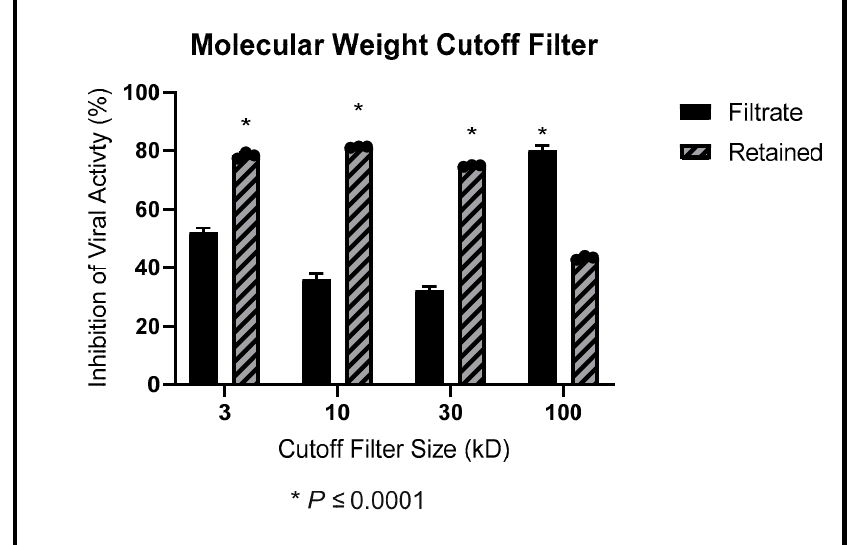
Figure 4. We passed through 3 kD, 10 kD, 30 kD, and 100 kD filters. The filtered and retained liquids were used to treat cells infected with 1 ng of HIV-1 NL4-3 . We show the average anti-HIV-1 NL4-3 inhibitory effects. Solid bars present the filtrate, and dashed bars represent the retained liquid.